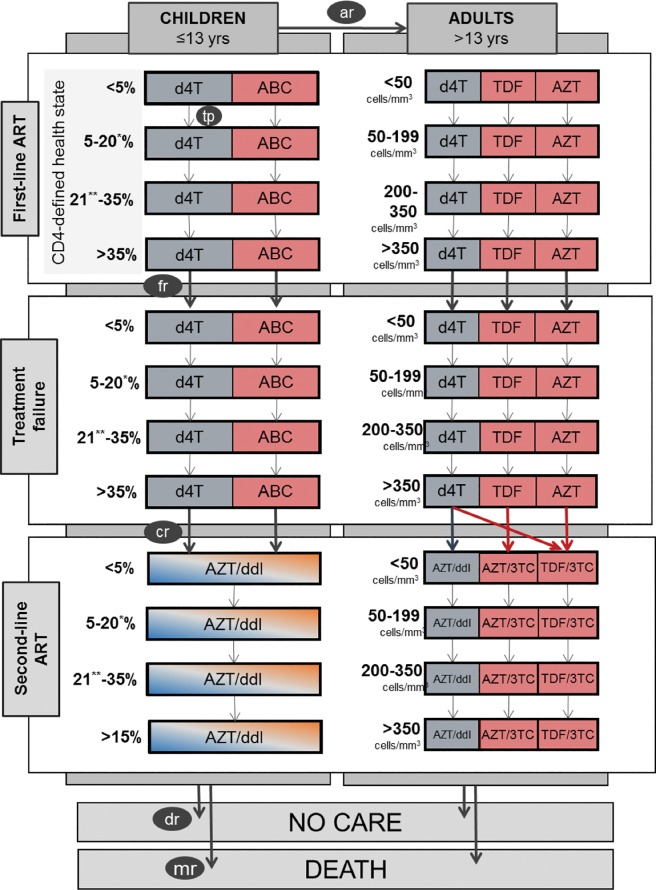
Health-state transition model.with ar: age rate, tp: transition probability, fr: failure rate, cr: rate of initiation of second-line ART, dr: default rate, mr: mortality rate. Blue arrows and boxes represent drug choices and transitions under the Old Guidelines scenario, red arrows and boxes represent the New Guidelines and Full WHO Guidelines scenarios. Drugs and transitions that are the same in all scenarios are represented in grey and white. For better legibility, rates are represented for the first row or column only; small black arrows represent movements in both directions; for drug choices, colours in the first row are representative of all rows; and only those drugs that change between scenarios are mentioned. *15% and **16% for children in the age group 6–13.